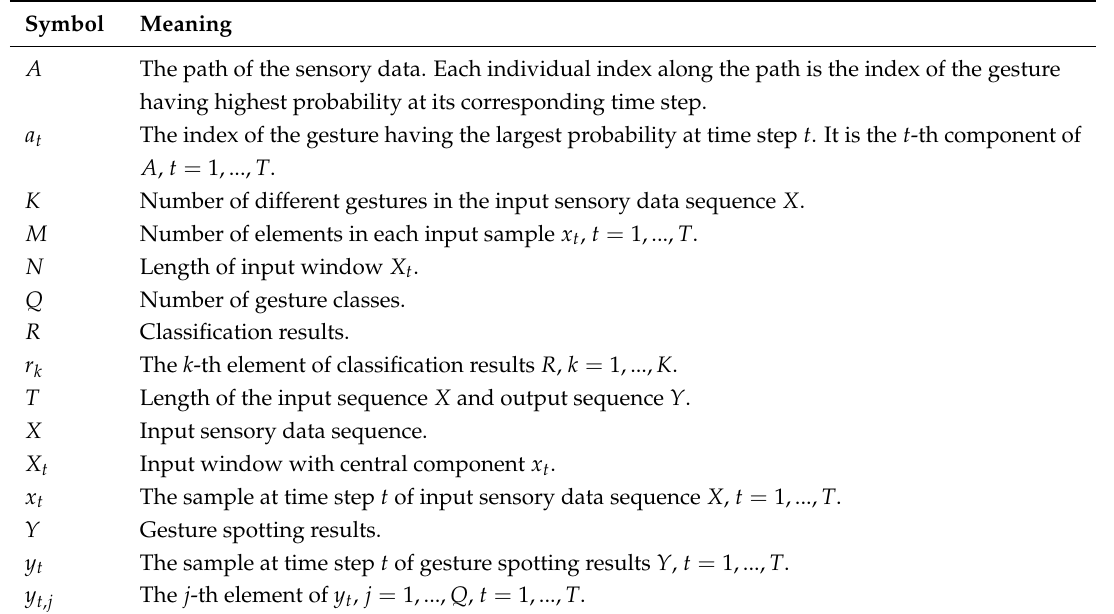
Table 1. A list of frequently used symbols in this